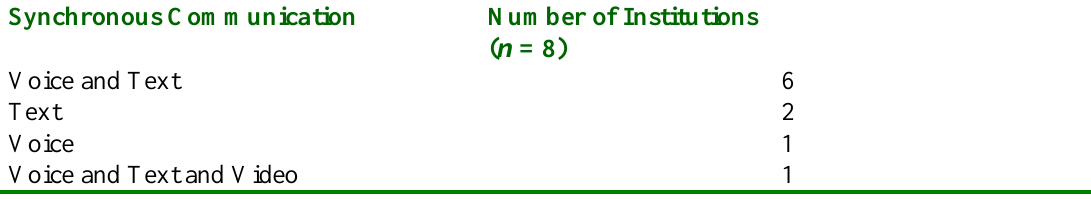
Table 2. Provision of synchronous communication in learner support reported by the eight institutions